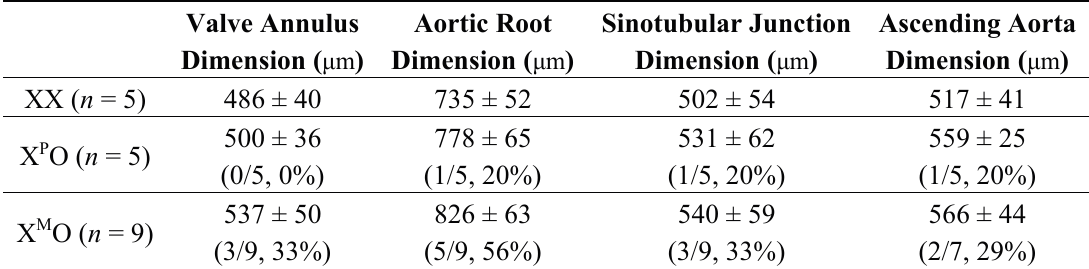
Table 2. Aorta Dimensions by Pathology in a Mouse Model of Turner Syndrome.